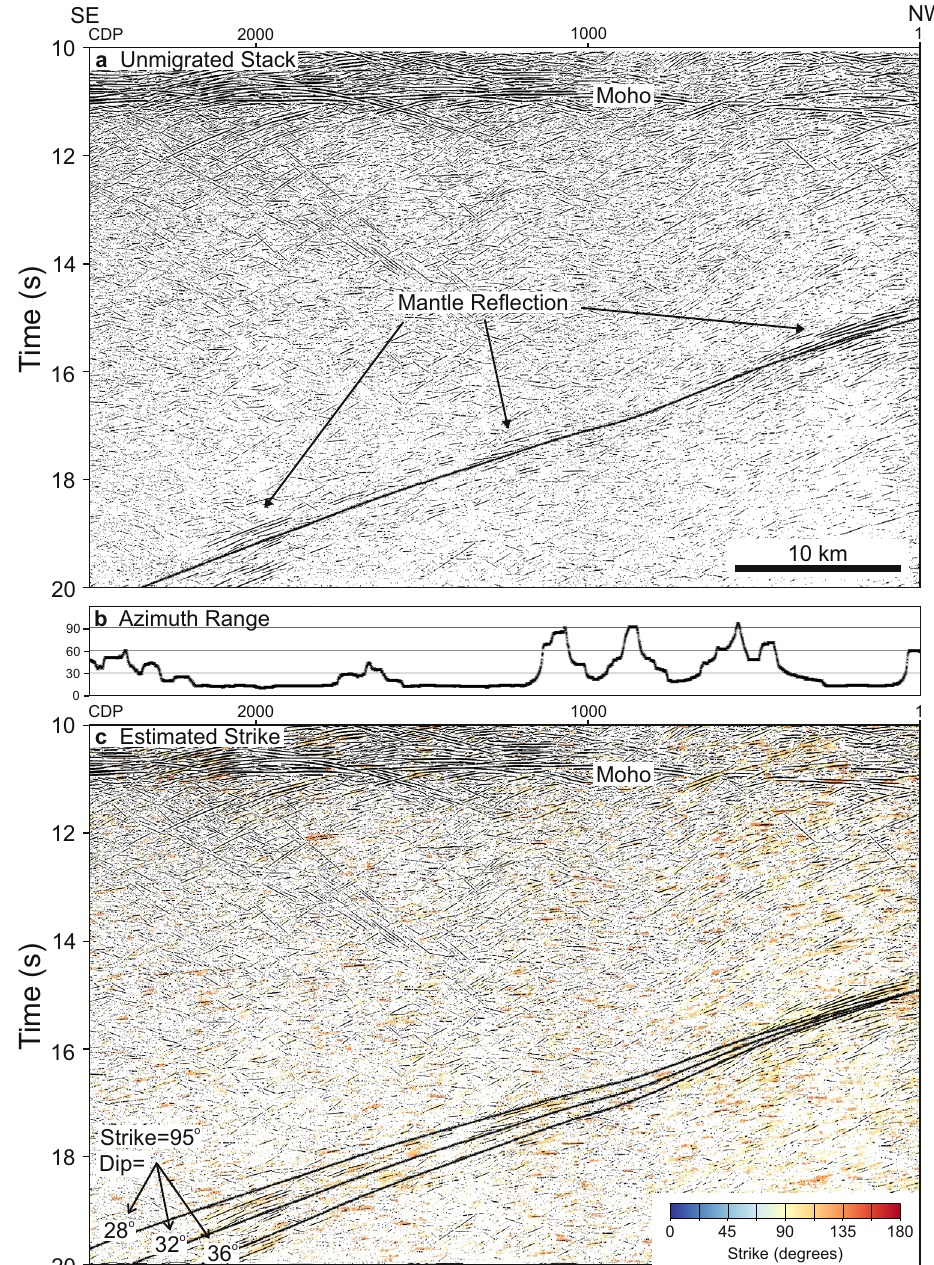
Fig. 3 Mantle re fl ections M1. a Unmigrated stack of line YU1. Superimposed solid lines, which represent the nearly identical travel times of three planar re fl ectors with dip/strike of 29°/090°, 32°/095°, and 36°/100°, all vary in a similar fashion to the mantle re fl ections. Smaller and larger values of strike cannot be fi t as well to the observed re fl ections. b Range of source-receiver azimuths included in the estimation of dip and strike along line YU1. This range is small where the line is almost straight. c Local prestack estimates of re fl ector strike where they lie between 090° and 120° superimposed on the stack section indicating that most strong mantle re fl ections exhibit strike values in this range. Superimposed solid lines indicate the travel times of three planar re fl ectors with a strike of 095°, and dips of 28°, 32°, and 36°, from which we infer that for a given strike the dip of the best fi tting planar interface can be determined to within